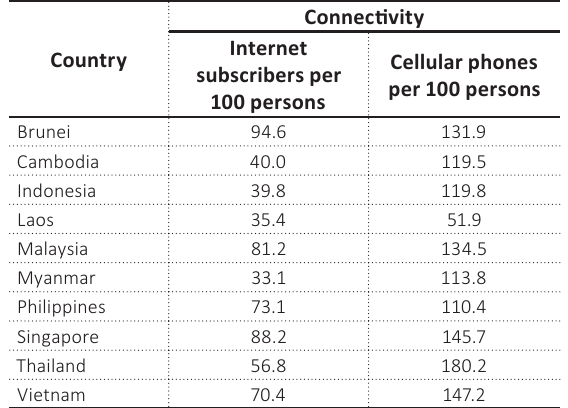
Source: ADB (2019).